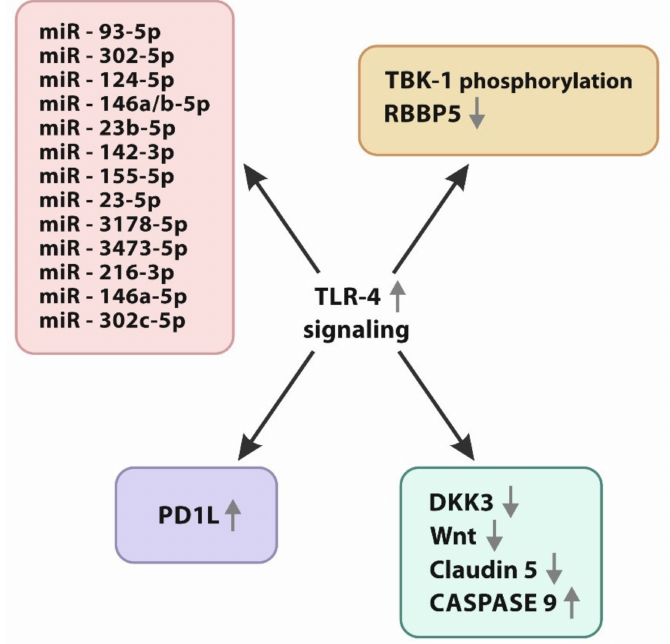
Figure 2. Potential targets for future immunotherapy concerning TLR-4 signaling in glioblastoma multiforme: Complex of miRNA molecules inhibiting TLR-4 signaling on di ff erent stages, programmed death ligand-1 (PD-1L) overexpression stimulated by TLR downsignaling, indirect retinoblastoma binding protein 5 (RBBP5) inhibition by TBK-1 phosphorylation resulting in antineoplastic activity, interplay between TLR-4 and Dickkopf-related protein 3 (DKK-3) inhibition, Wnt pathway signaling restriction, claudin-5 level reduction, and caspase-9 elevation and caspase-3 decrease as a pro-oncogenic cascade after TLR-4